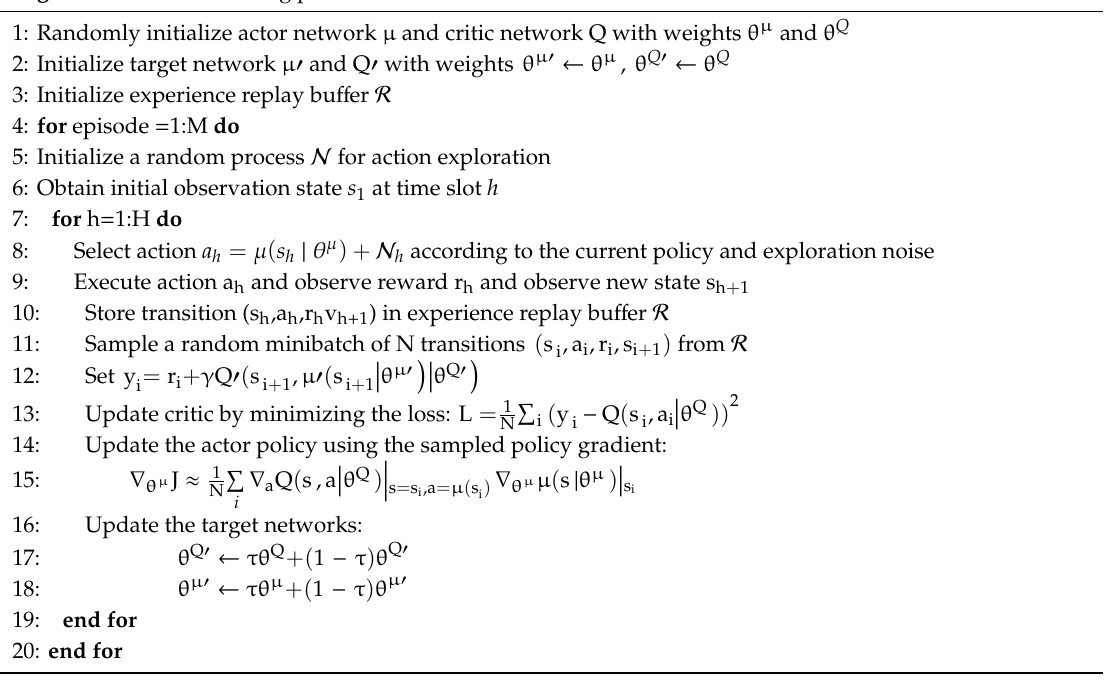
Algorithm 1 DDPG training